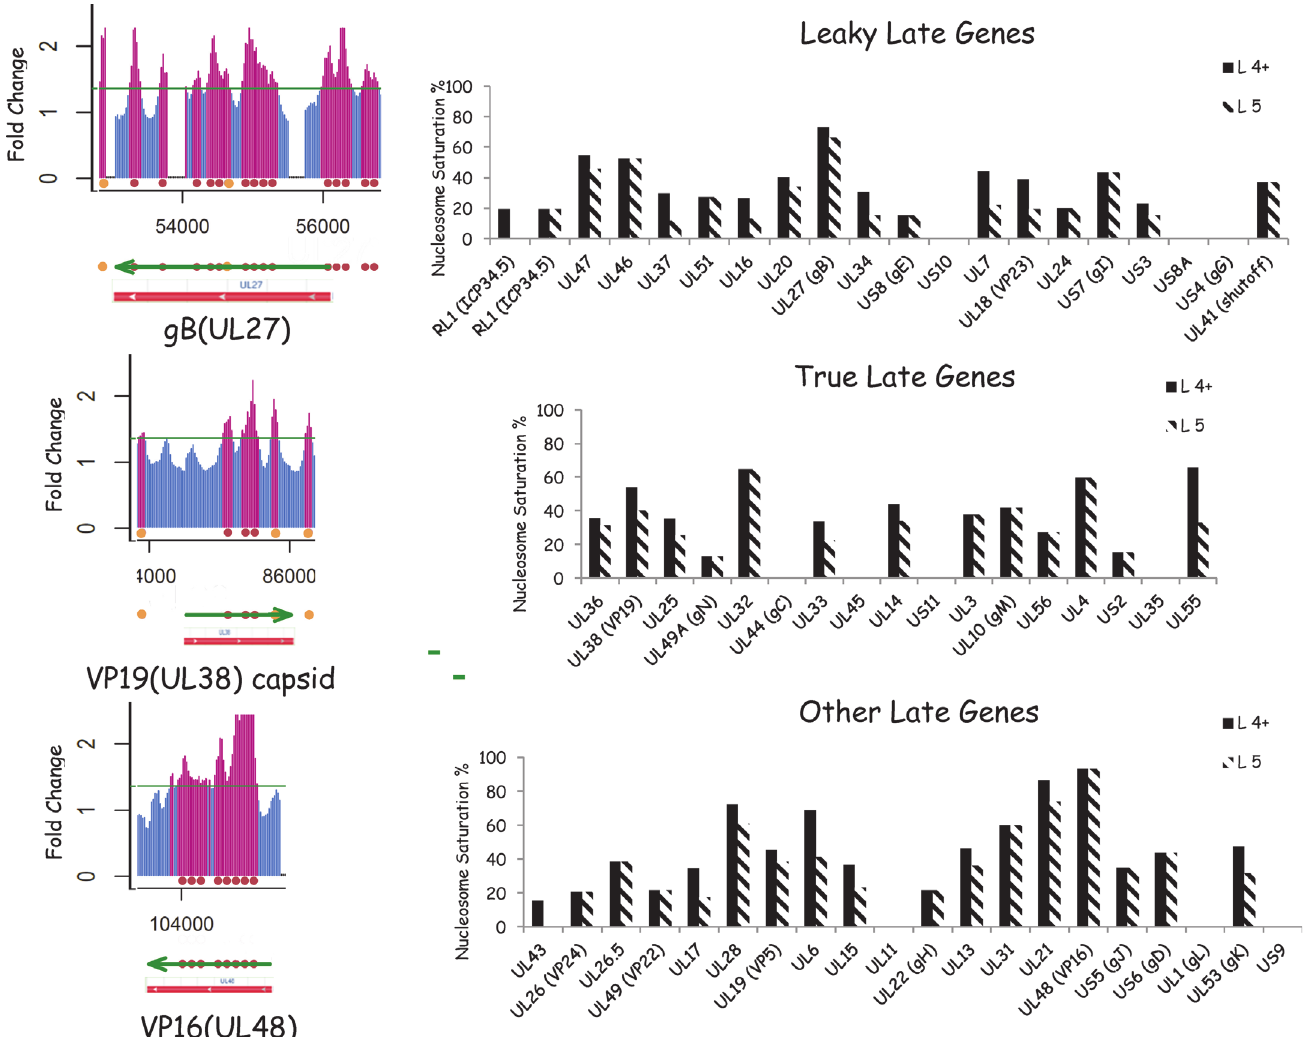
Fig 6. Nucleosome on Late Genes. A . The nucleosome signal is shown in the region covering the late gene VP16 (UL48) a tegument protein and transactivating factor for transcription of IE genes, VP19 (UL38) a capsid protein, and gB (UL27) a glycoprotein found in the viral membrane. Spaces in the graph lines are “ poorly performing ” oligos. Below the array signal information we have mapped the transcribed gene and the orange balls indicate the predicted position of nucleosomes. Gene features from the NCIB database are also shown. B . Nucleosome Saturation for select L genes. The predicted nucleosomes for each L gene were compared to the maximum number of nucleosomes (assuming a 200nt/nucleosome repeat pattern) to give the nucleosome saturation, which is expressed as a %. Late genes were sub-grouped into true late genes (which are not expressed prior to DNA replication; B1) leaky late genes (which are expressed at a low level prior to DNA replication; B.2) and Late genes (which were not sub-characterized;